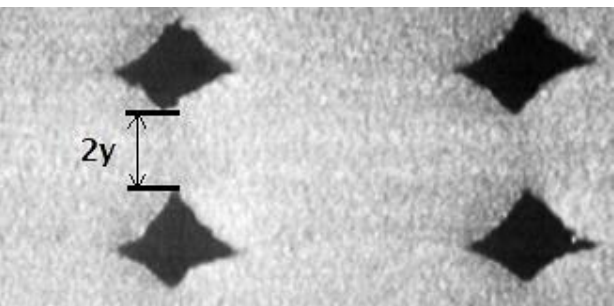
Figure 6. Partial neck growth voids,[29]: cross sectional view of an FDM laminate, where 2y is the neck growth between adjacent rasters. Reprinted with permission from [22], 2008, Emerald Publishing, Bingley, UK.